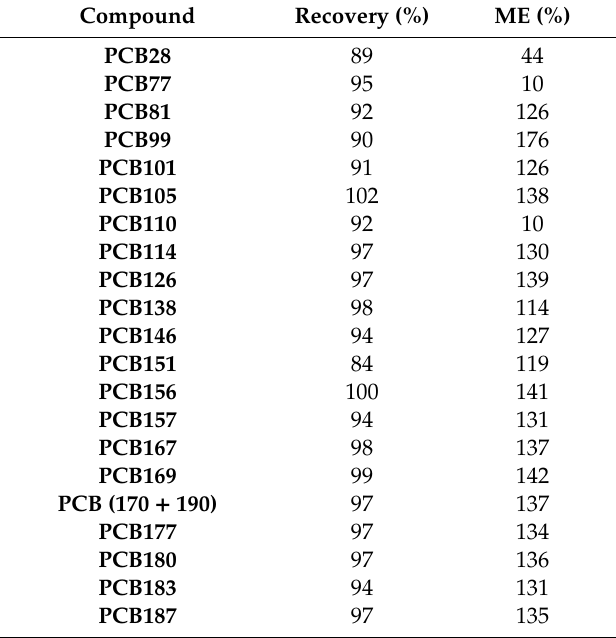
Table 2. Recoveries and matrix e ff ects (ME) of analytical procedure for each